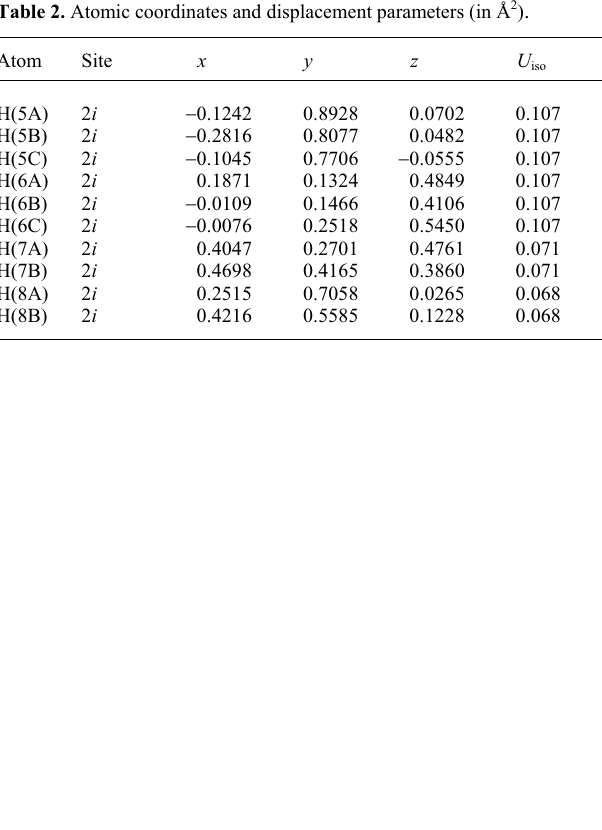
Table 2. Atomic coordinates and displacement parameters (in Å 2 )